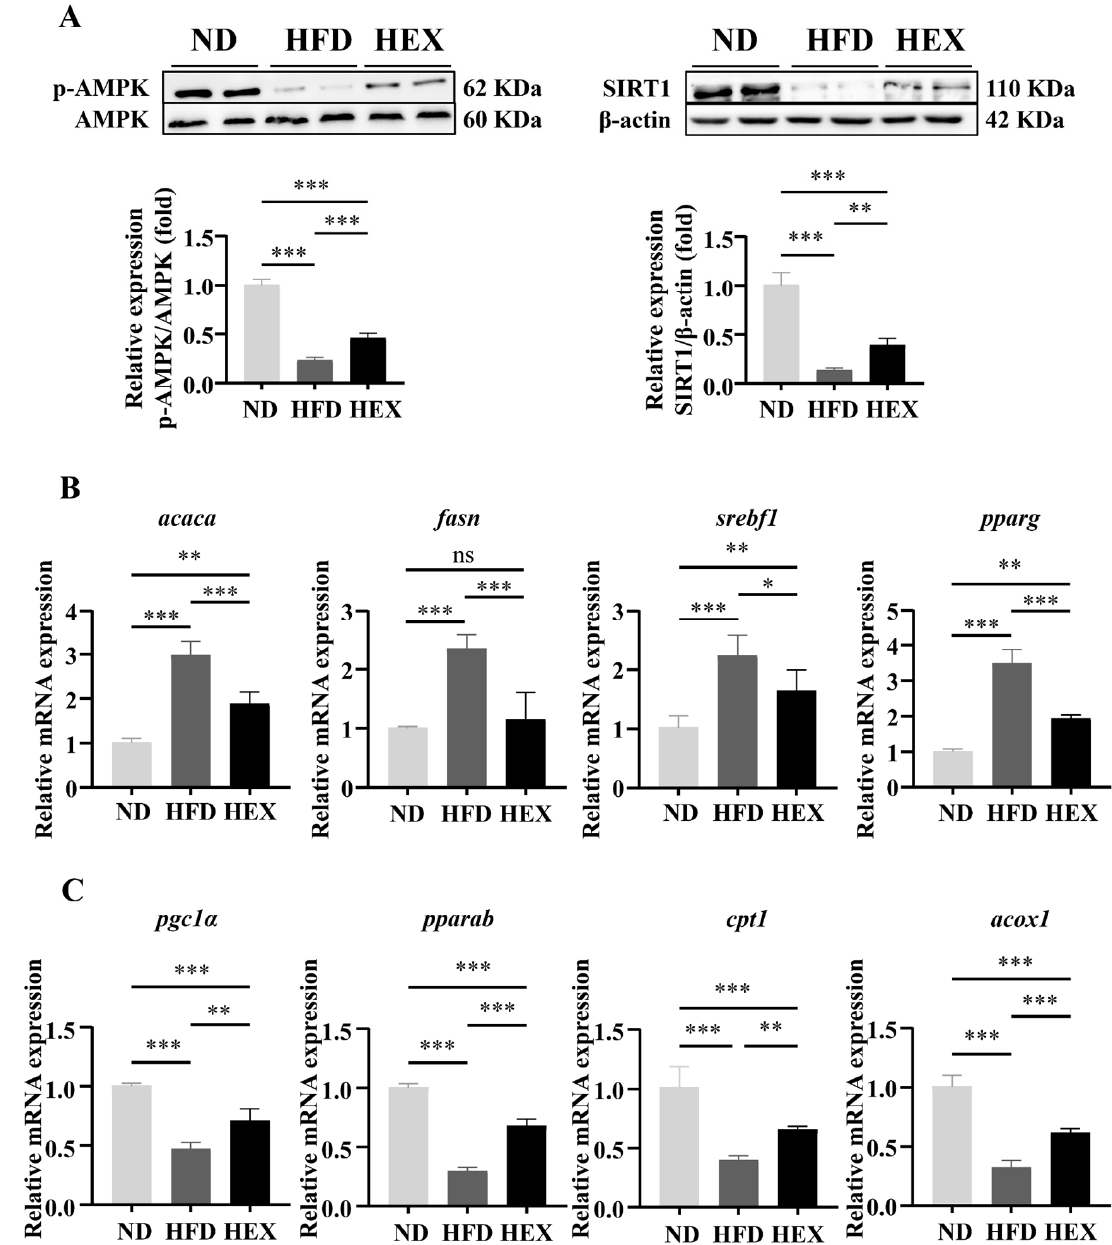
Figure 2. SIRT1/AMPK signaling and lipid metabolism in zebrafish livers. ( A ) Western blot representing SIRT1/AMPK signaling in 9-month-old zebrafish livers ( n = 8). ( B ) Expression of lipogenesis-related genes ( n = 6). ( C ) Expression of β -oxidation-related genes in 9-month-old zebrafish livers ( n = 6). *, p < 0.05, **, p < 0.01, ***, p < 0.001. Data represents the mean, and error bars represent SEM. NAFLD, non-alcoholic fatty liver disease; ND, normal diet; HFD, high fat diet; HEX, high-fat diet plus exercise.